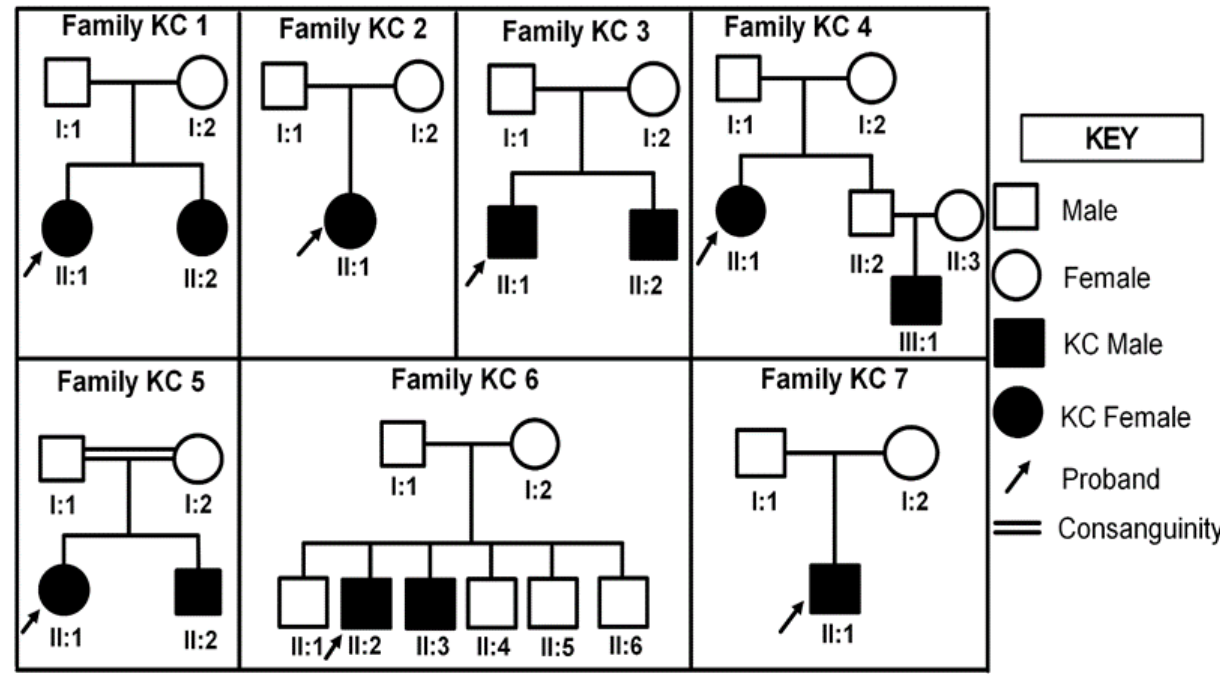
Figure 1. Pedigrees for seven autosomal recessive KC families. In the pedigrees white circles represent unaffected females whereas white squares represent unaffected males. Filled symbols represent affected individuals. Double lines indicate consanguineous marriage between parents.